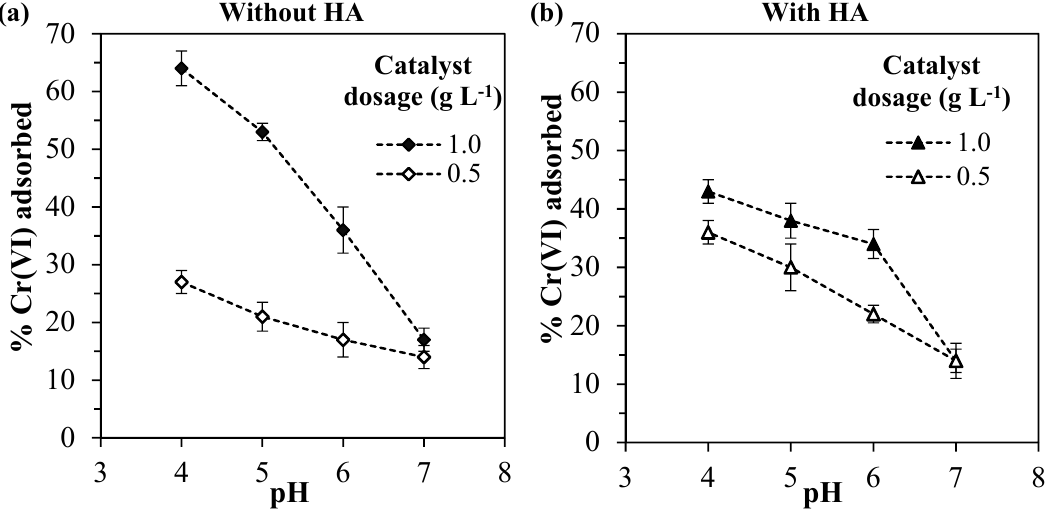
Figure 2. Percentage of Cr(VI) adsorbed for different pH values and catalyst dosages for the systems: ( a ) without humic acid and ( b ) with 10 mg L − 1 of humic acid.